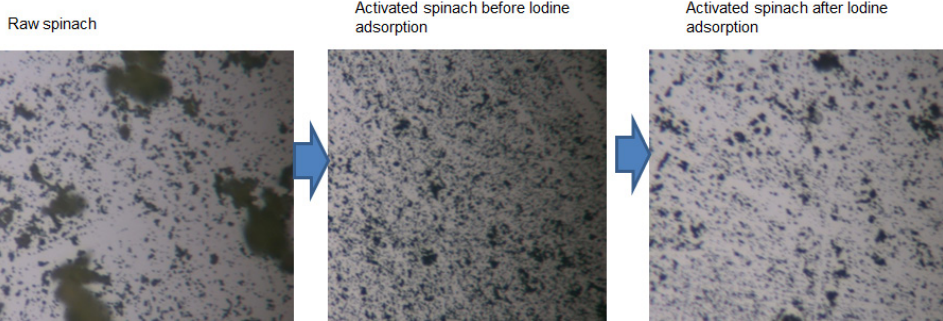
Fig. 3. Optical images of DSL and ASL-2 before and after adsorption of iodine